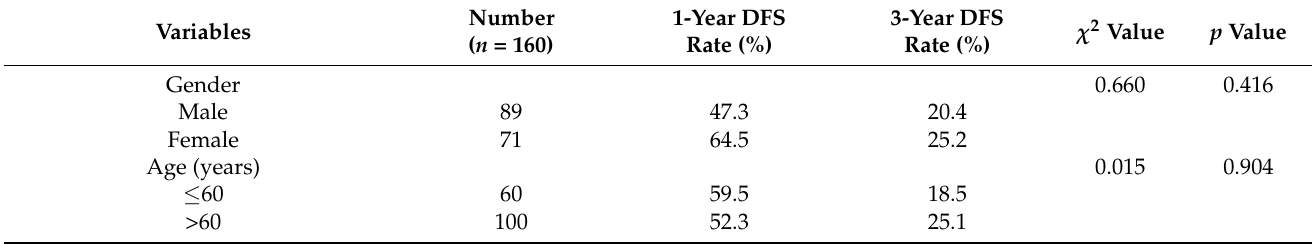
Table 5. Univariate analysis of postoperative tumor recurrence in pancreatic cancer